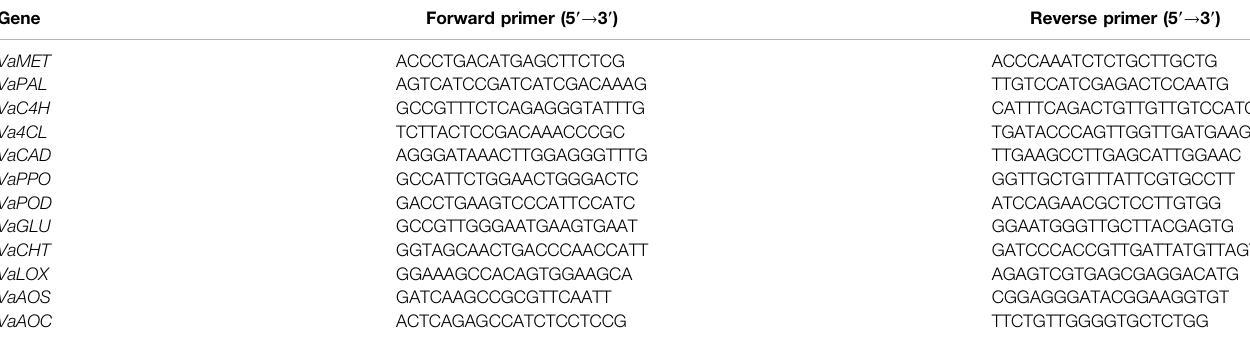
TABLE 1 | Primer sequences for fl uorescence